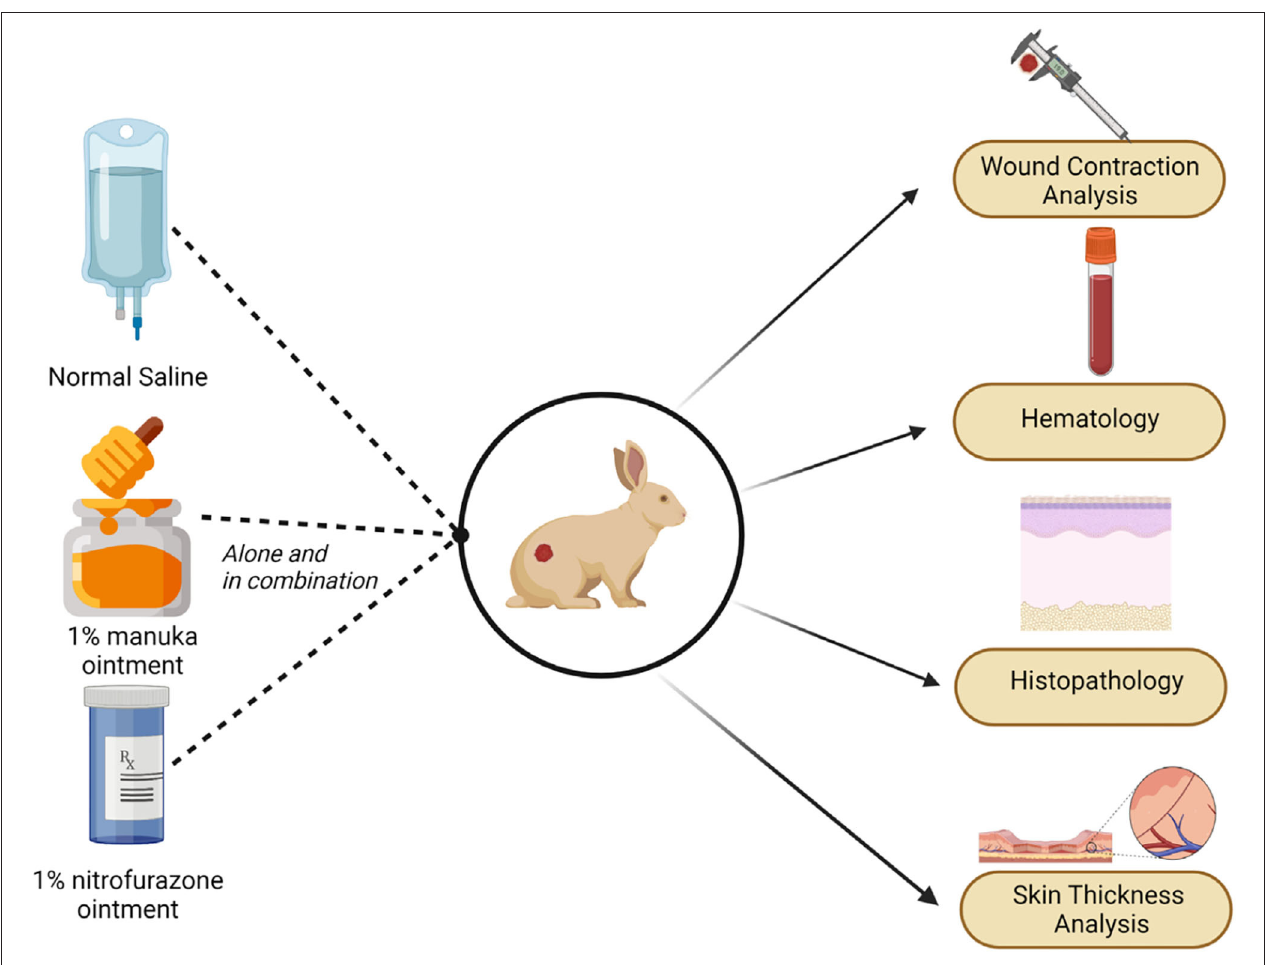
FIGURE 1 | The schematic presentation of the experiment.